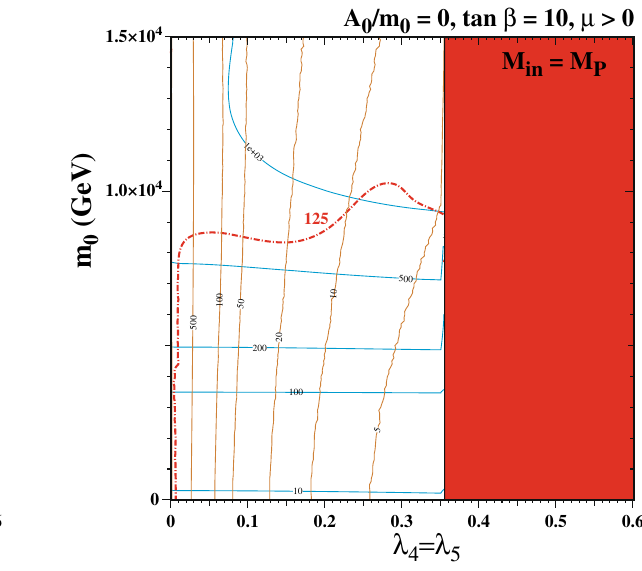
Fig. 6 Representative (λ 4 = λ 5 , m 0 ) planesintheFSU(5)GUTmodel with M in = 10 16 . 5 GeV ( M P ) for the left (right) panel. The brown shaded region in the left panel is excluded because the LSP is charged,